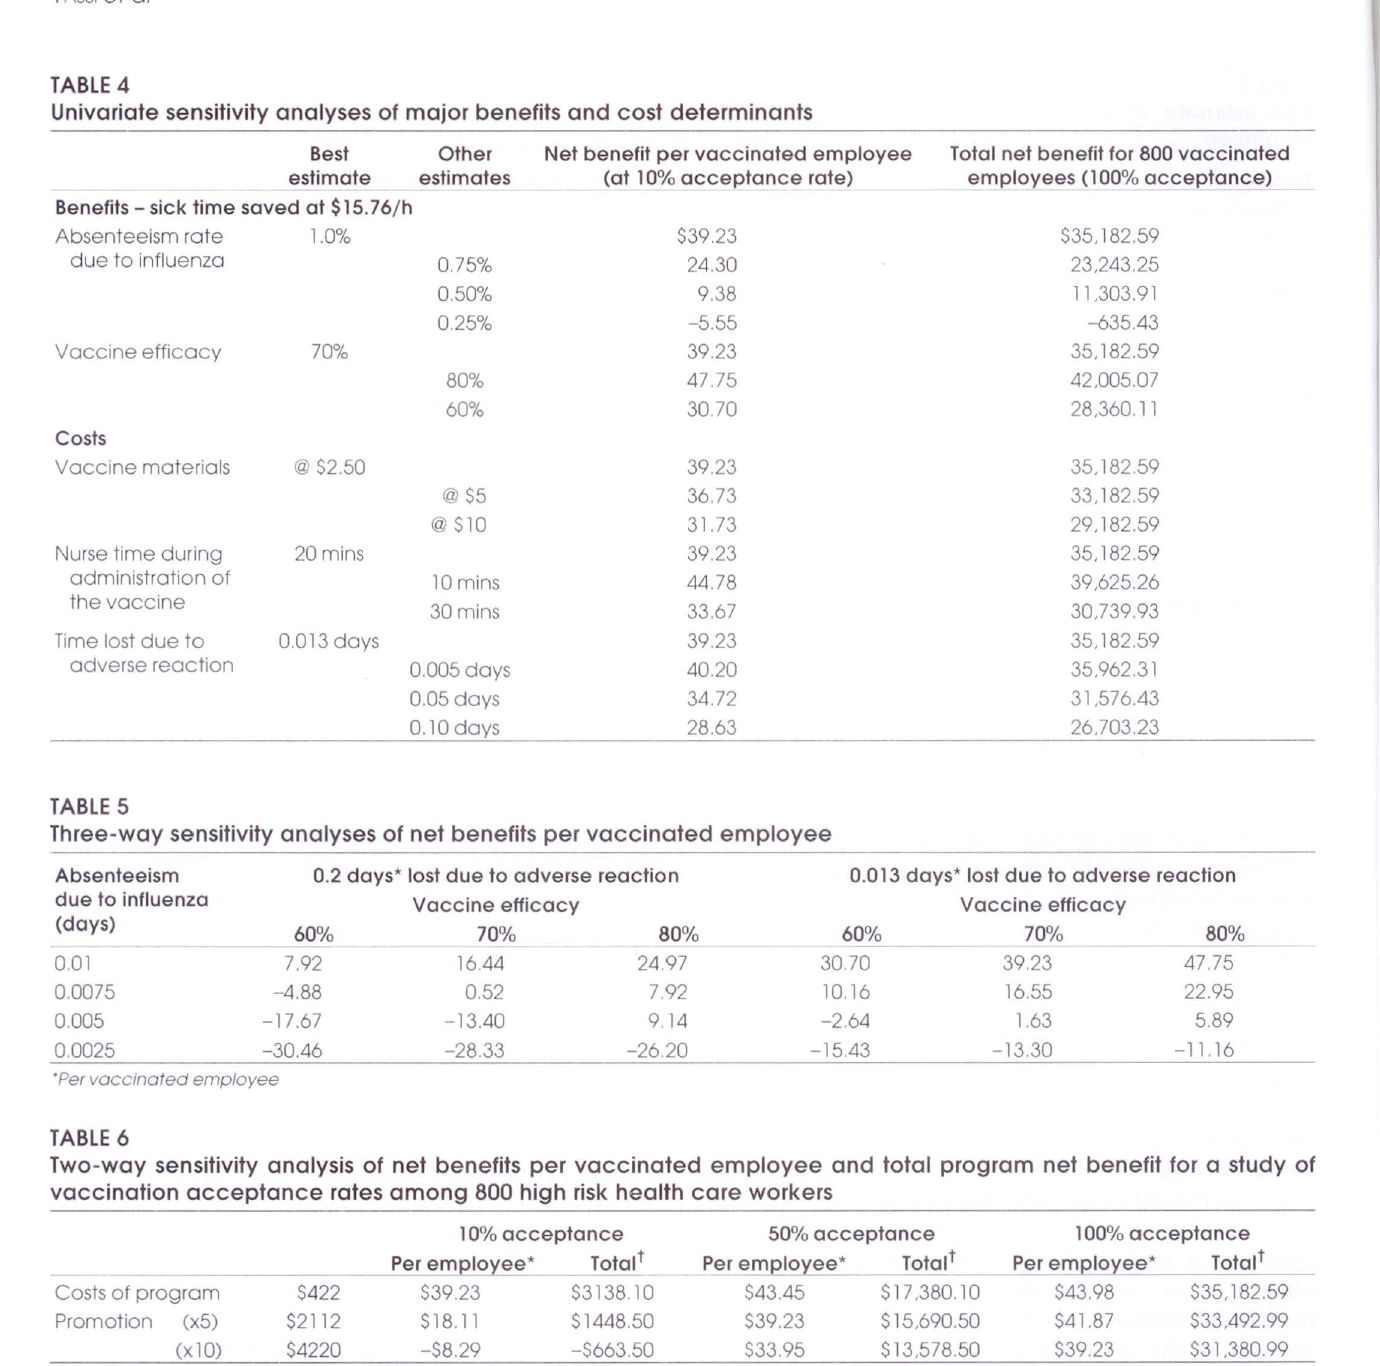
Univariate sensitivity analyses of major benefits and cost determinants Best Other estimate